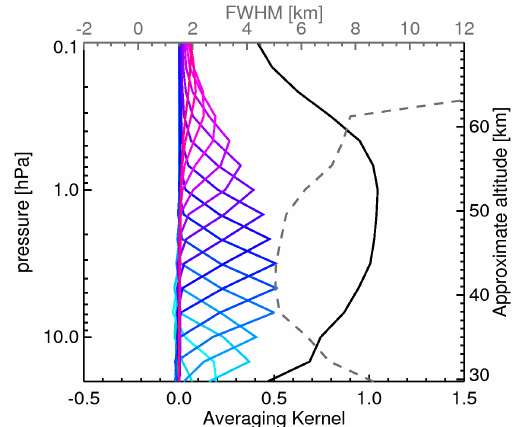
Fig. 2. Monthly zonal mean for January 2005 of MLS BrO obser- vations for the three versions discussed in the text for ascending (mainly daytime) and descending (mainly nighttime) phases of the orbit. The dataset MLS L2 is the standard production algorithm de- scribed by Kovalenko et al. (2007), MLS OL1 is the “off-line” al- gorithm described by Livesey et al. (2006a) and MLS OL2 is the dataset introduced here. The region between the white dashed lines indicates where the MLS ascending-descending difference are suit- able for scientific use.